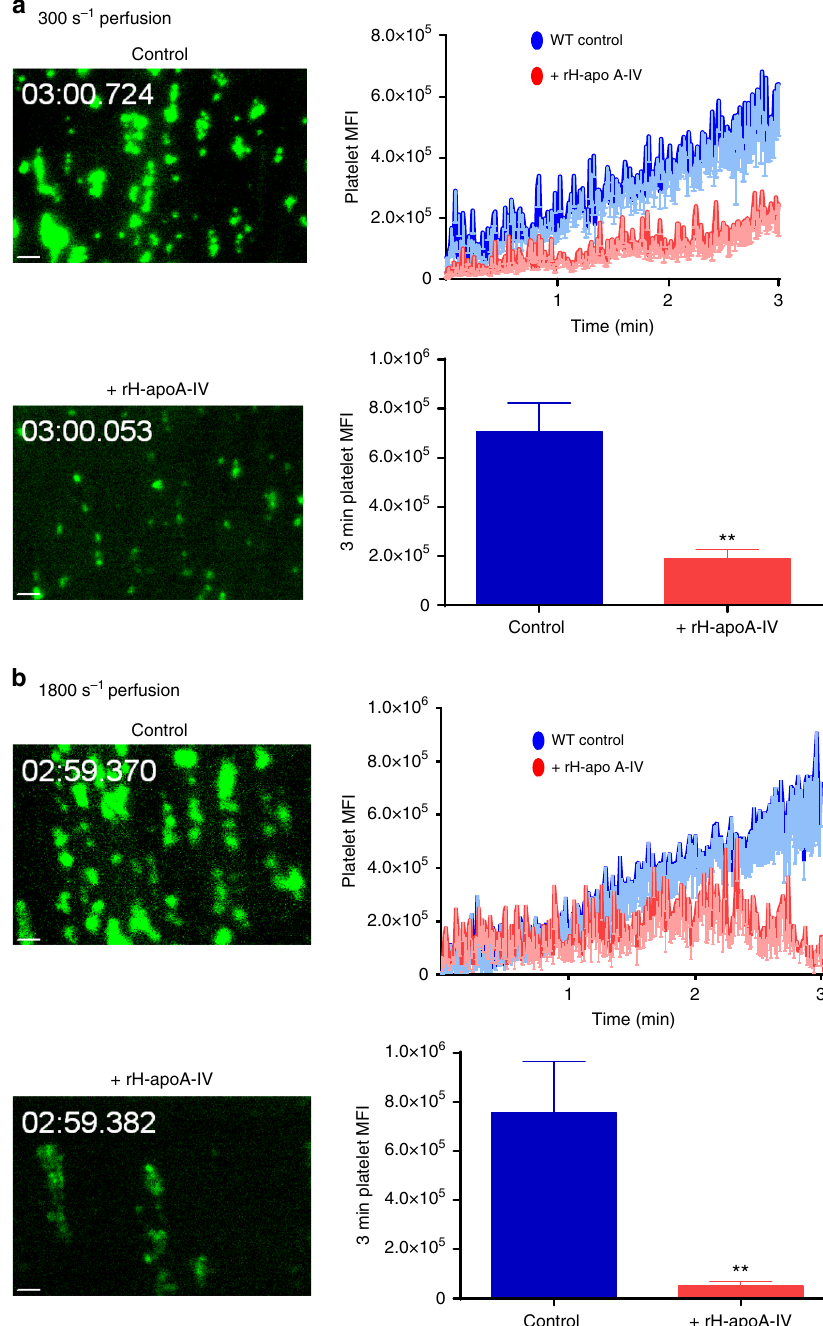
Fig. 6 ApoA-IV inhibits human thrombus growth in vitro. Recombinant human apoA-IV inhibited thrombus formation in human blood under both low ( a ) and high ( b ) shear rates. Representative images of thrombus formation (green) in four individual experiments were shown. n = 9 thrombi. Unpaired, two- tailed Student ’ s t -test. Mean ± SEM. ** P < 0.01. Scale bars: 10 μ m ( a , b